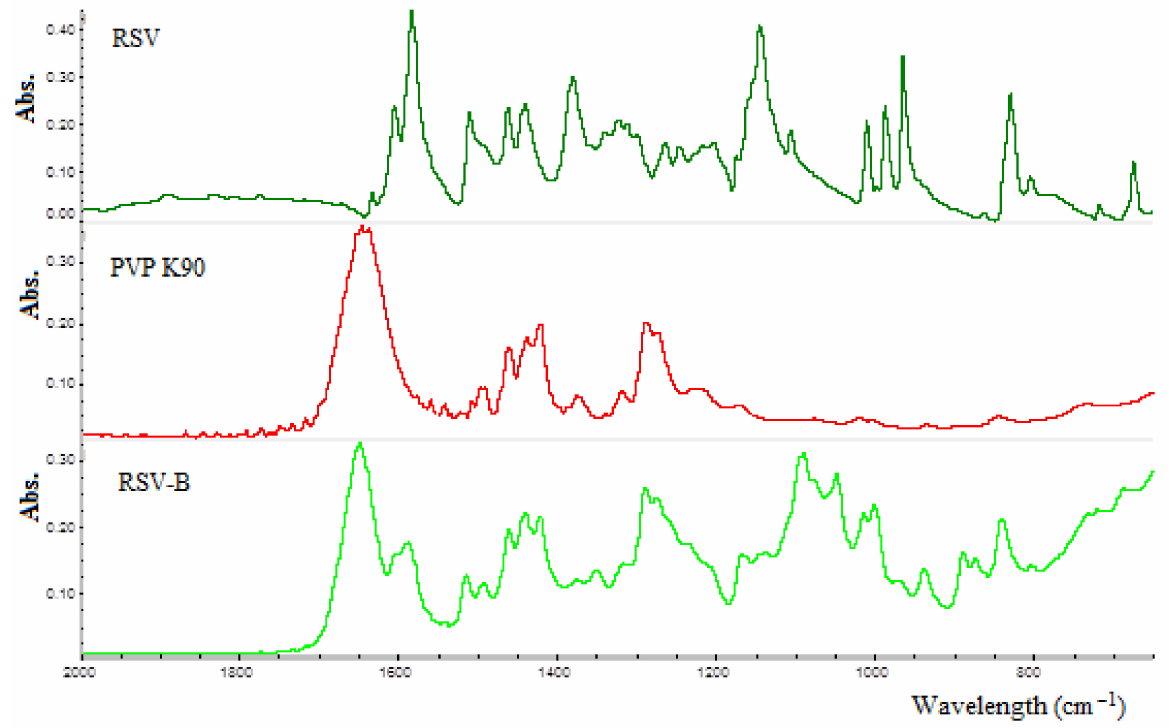
Figure 8. ATR-FTIR spectra of pure RSV (black), PVP K90 (red) and RSV-B powder